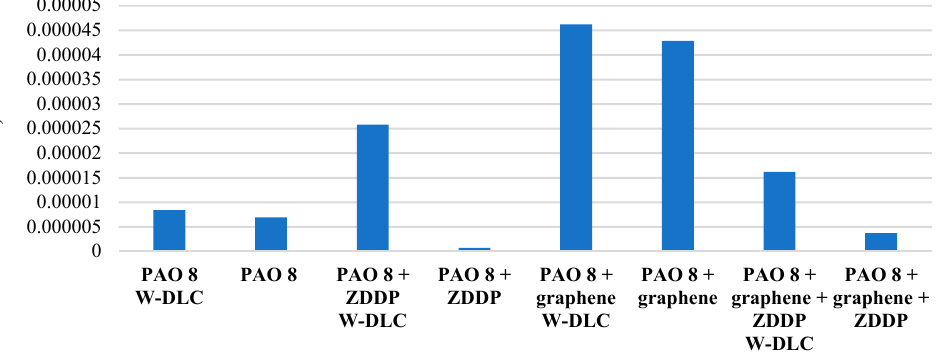
Figure 7. Wear rate of discs after tribological tests.